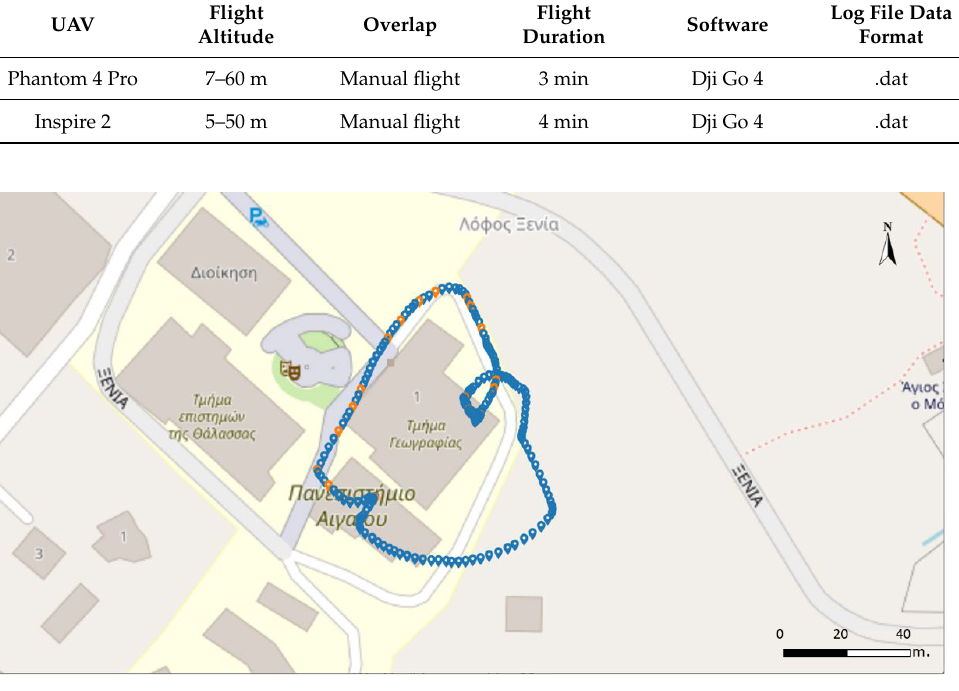
represent raw positions and orange-colored points represent recording positions.